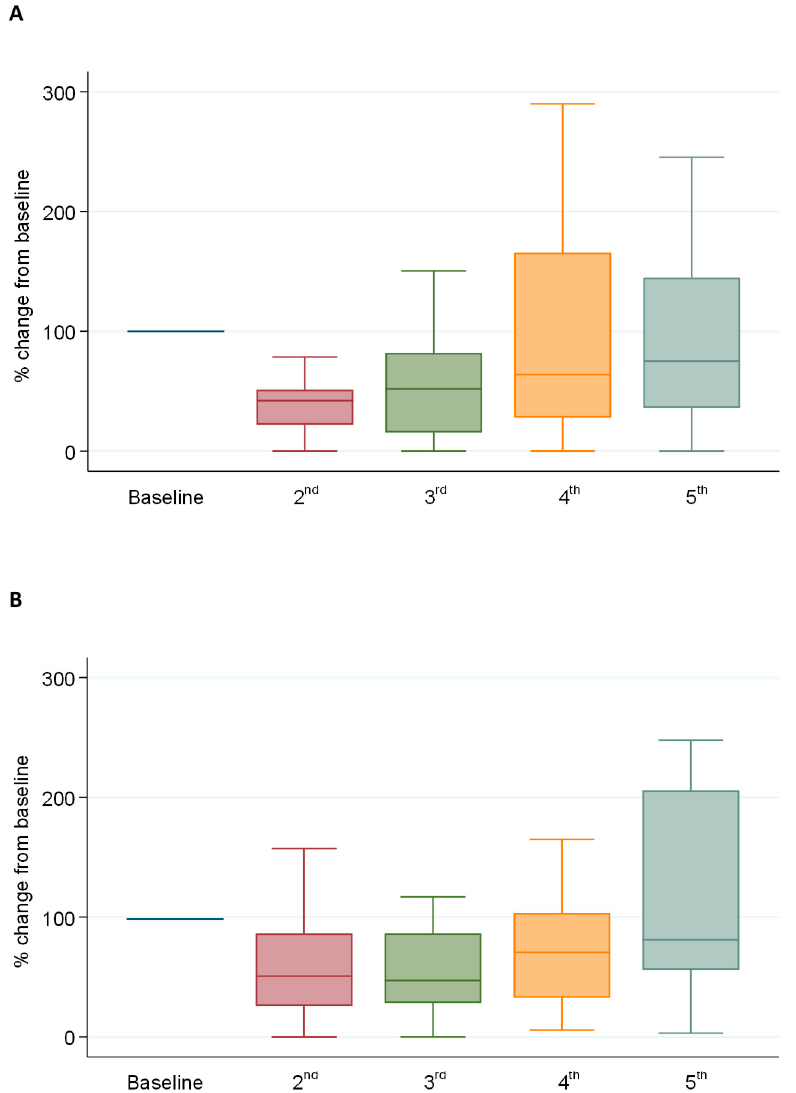
Figure 5. ( A ) methylated circulating tumor (ct) ctDNA and ( B ) mutated ctDNA. Baseline and five serial plasma samples were available from 40 and 23 patients, respectively. The boxplots of medians show the longitudinal changes of normalized values of the fraction of ctDNA.